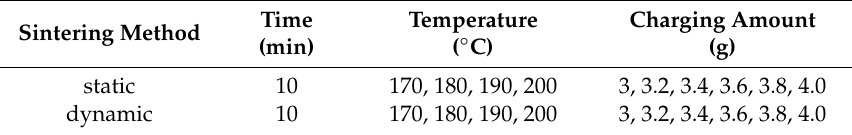
Table 1. The sintering conditions of the examined samples.